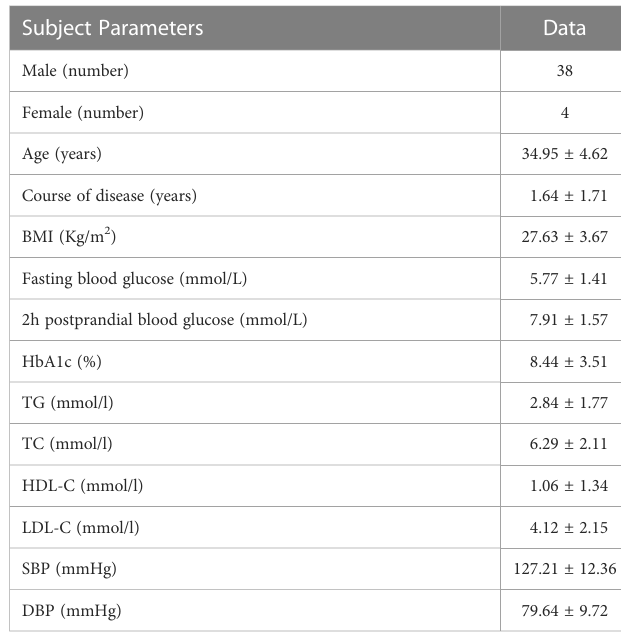
TABLE 1 General data and metabolic indexes of subjects before intervention